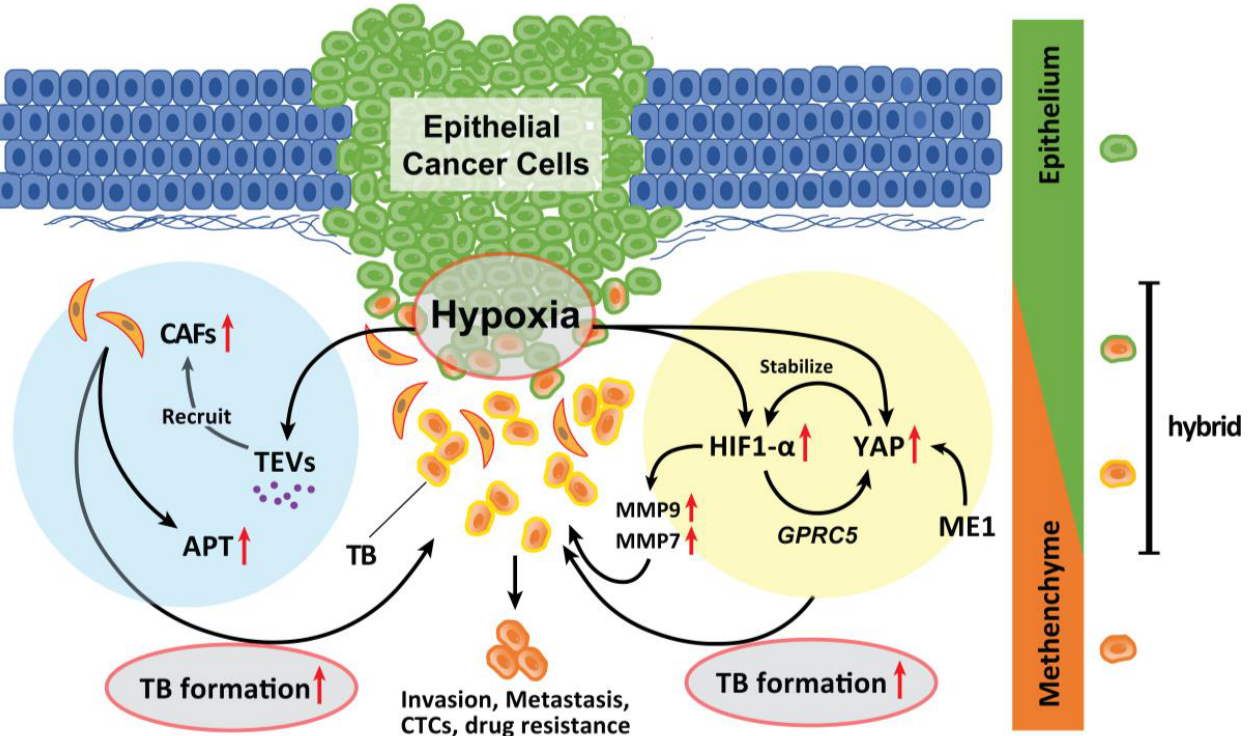
Figure 2. Role of hypoxia in the formation of TB. Hypoxia in advanced TME promotes TB development. Genes whose expression is induced by HIF-1 α activation by hypoxia promote EMT. YAP is activated in a hypoxic TME and was abrogated by the knockdown of ME1 which promotes the Warburg effect in cancer cells and induces EMT. YAP activation is a significant factor that promotes the EMT phenotype and is deeply involved in the progression of the tumor. In a hypoxic situation, YAP activation is responsible for the upregulation of GPRC5A by binding to HIF-1 α . Then, activated YAP also stabilizes HIF-1 α and enhances its action. The expression of MMP9 and MMP7 is also up- regulated by HIF-1 α activation. Moreover, hypoxic TME can induce tumor cells to secrete enhanced amounts of TEVs. The dynamic intercellular crosstalk that is mediated by TEVs mobilizes oncogenic factors, relocalizes CAFs to tumor sites, p-EMT and APT development, and TB formation which sustains cancer progression and